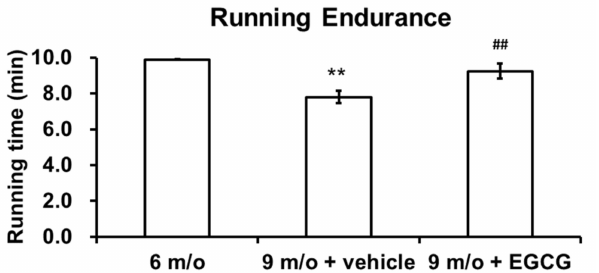
Figure 4. The results of the running endurance test. The running endurance was compared among the animals at 6 months of age (6 m/o), at 9 months of age treated with PBS (9 m/o + vehicle), and at 9 months of age treated with EGCG (9 m/o + EGCG). Running endurance was significantly decreased with age; there was a significant reduction in the running endurance of guinea pigs treated with PBS at 9 months of age compared with animals at 6 months of age. The average running endurance was 9.2 min in the EGCG-treated guinea pigs, which was no different from the endurance of younger guinea pigs (6 months old) and significantly better than that of the same-age animals treated with PBS ( n = 8 in each group; ** p < 0.01 versus animals at 6 months of age; ## p < 0.01 versus the animal at 9 months of age, treated with